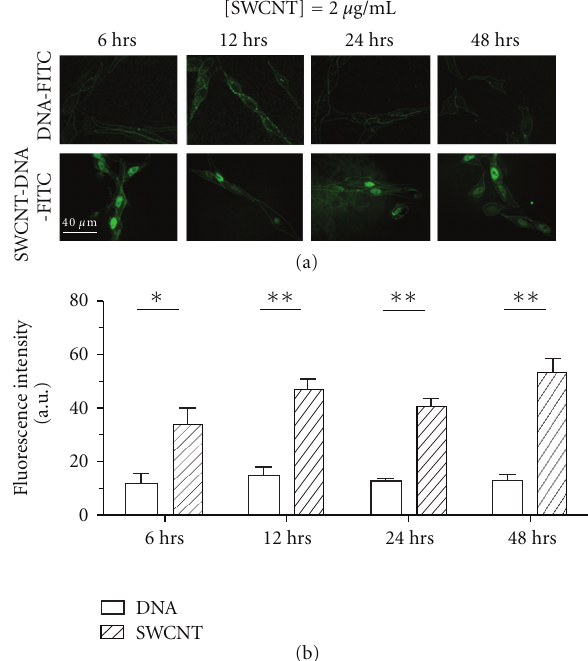
Figure 2: Distribution and fluorescence intensity of SWCNT-DNA- FITC (2 µ g/mL) and DNA-FITC (2 µ g/mL) at various time intervals within 48 hrs. (a) Representative projection images suggest that SWCNT-DNA-FITC conjugates are distributed in microvascular EC nuclei (lower panel); DNA-FITC appears to be restricted to the cytoplasm (upper panel). (b) SWCNT-facilitated DNA transport into microvascular ECs. Fluorescence intensity was quantitatively assessed by measuring optical density of confocal images as described in Materials and Methods. The P -values less than 0.05 and 0.01 are expressed as ∗ and ∗∗ , respectively ( n = 3–11). The scale bar is applicable to all